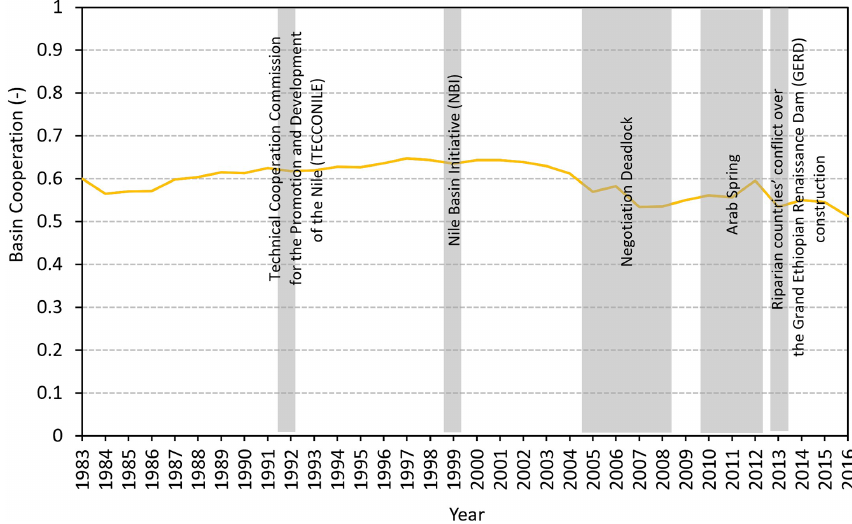
Figure 7. Simulated cooperation in the ENB (BC) with independent information on key events from 1983 to